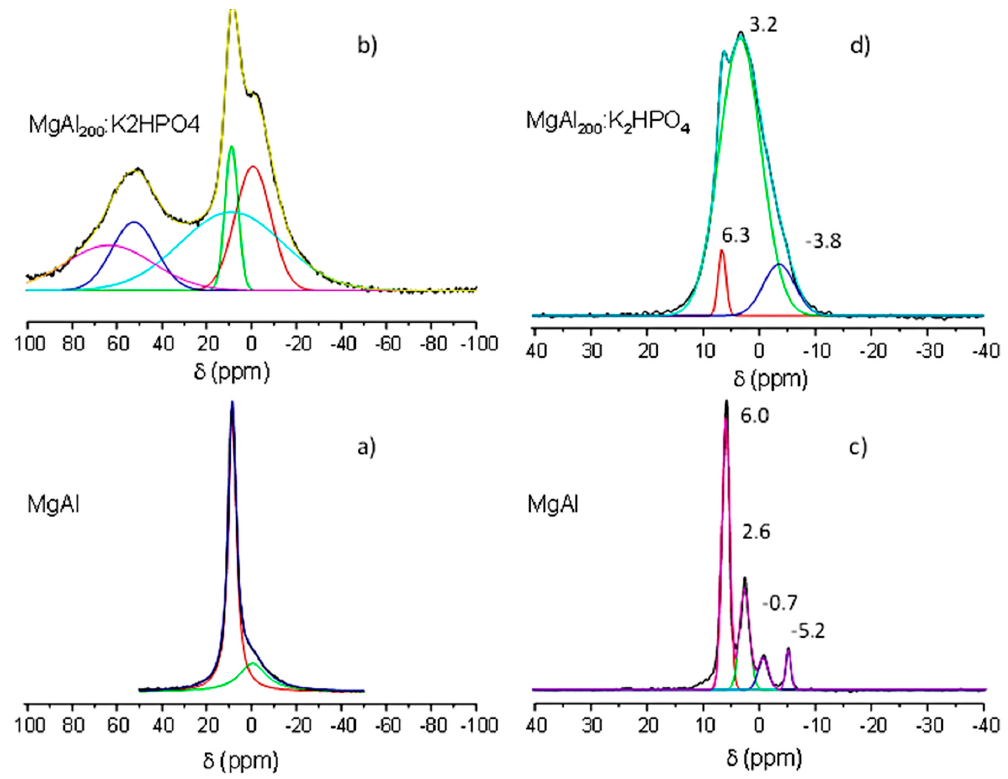
Figure 5. 27 Al NMR spectra of MgAl ( a ); and MgAl 200 /K 2 HPO 4 ( b ); and 31 P NMR spectra of K 2 HPO 4 ( c ); and MgAl 200 /K 2 HPO 4 ( d ).